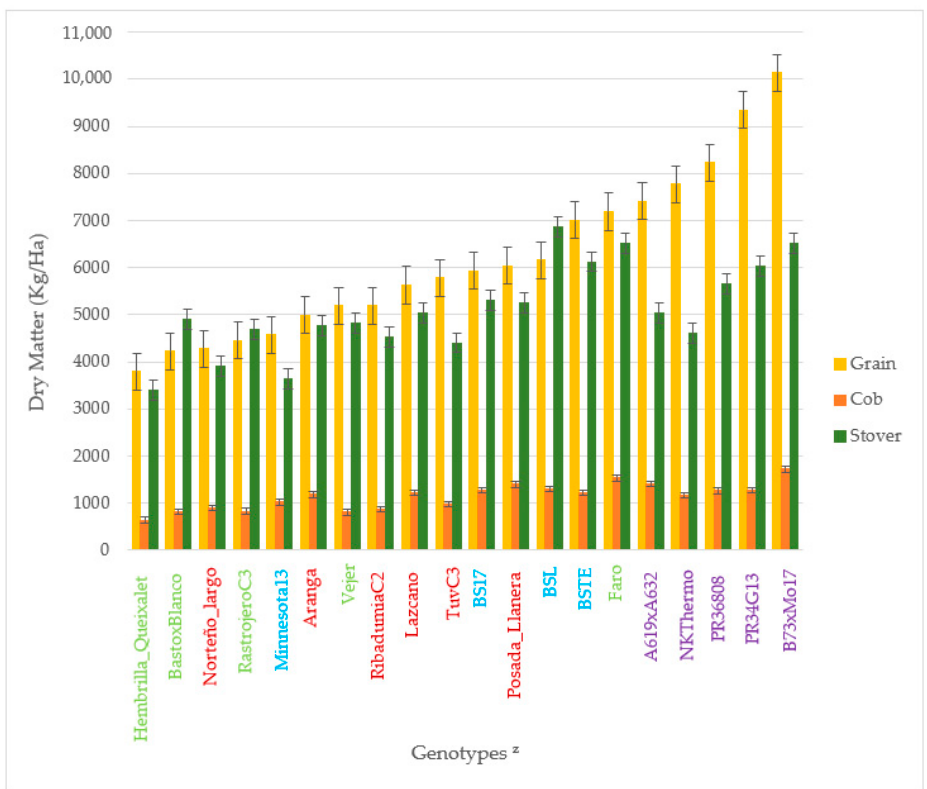
Figure 1. Yield in dry matter amounts for grain, cobs, and stover of 20 maize genotypes grown at four environments in Galicia, Spain, in 2010 and 2011. Ordered in ascending order for grain yield. z Genotypes are colored by origin: EU Atlantic (maroon), EU Mediterranean (green), hybrid (purple), and US Corn Belt (blue).